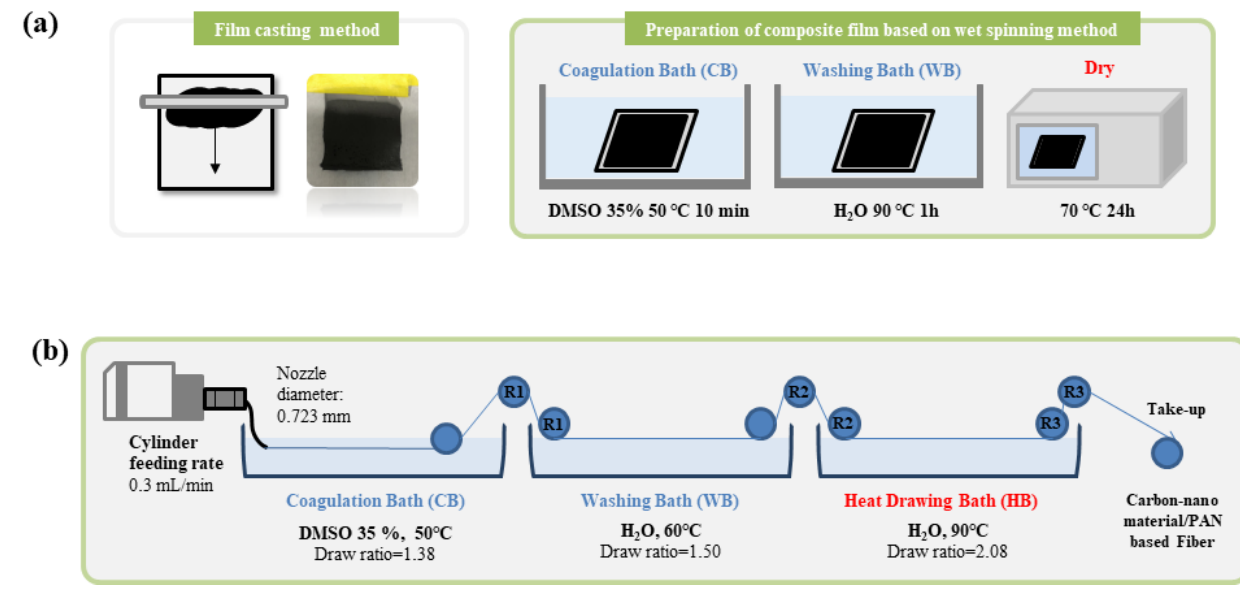
Figure 1. Schematic of the preparation process of ( a ) the PAN-based composite film and ( b ) wet spinning used in this study.